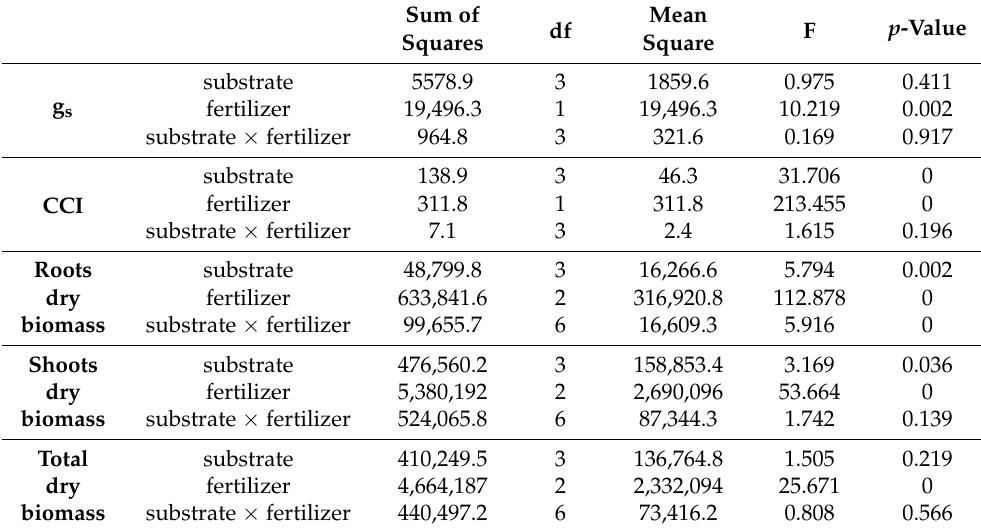
Table 4. Analysis of variance for the interaction between substrates (peat; peat with perlite; peat with vermiculite; peat with perlite and vermiculite) and fertilizer (control treatment; quick-release fertilizer; controlled-release fertilizer) in all parameters analyzed. Sum of